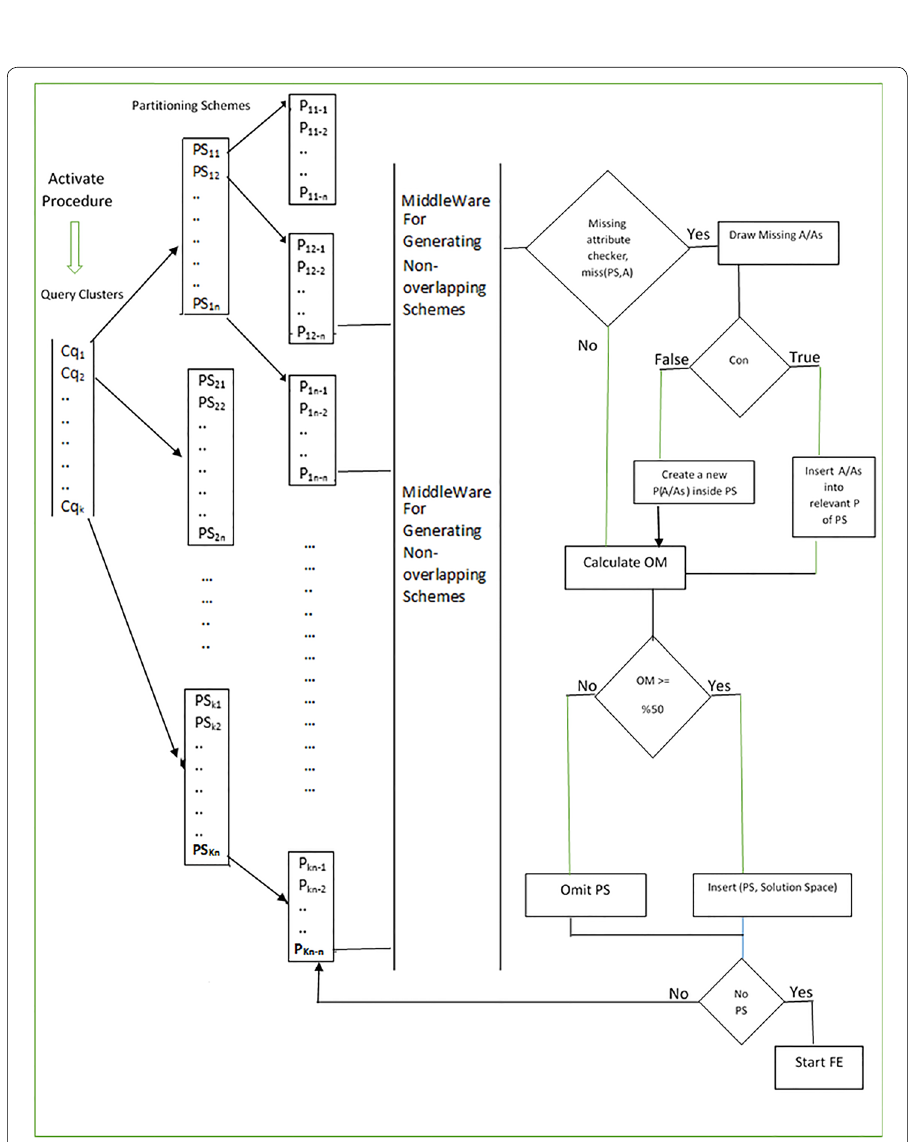
Fig. 2 Refinement procedure diagram: exhibit the steps taken by refinement procedure to produce disjoint